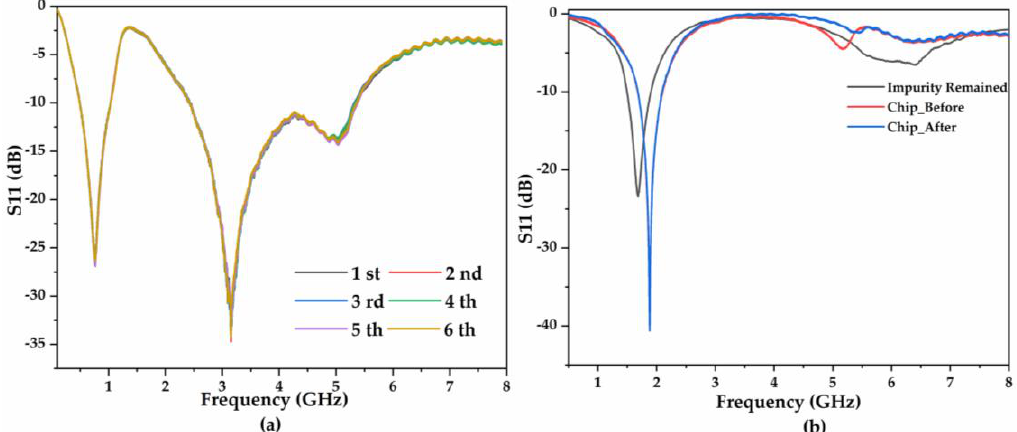
Figure 4. Pre-reliability and reusability investigation. ( a ) Six experiments for testing the 150 mg/dL glucose solution. ( b ) Unloaded chip resonance performance before and after the experiment.